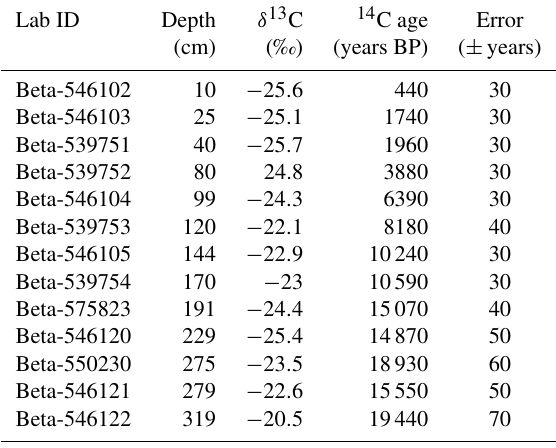
Table 2. AMS radiocarbon dates for Gahai